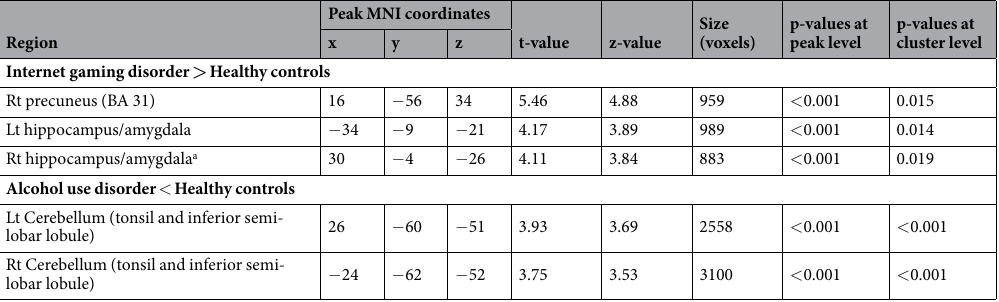
Table 2. Brain regions showing significant changes in cortical volume among Internet gaming disorder, alcohol use disorder and healthy controls groups. Lt, left; Rt, right; BA, Brodmann area. a The cluster size did not reach significant